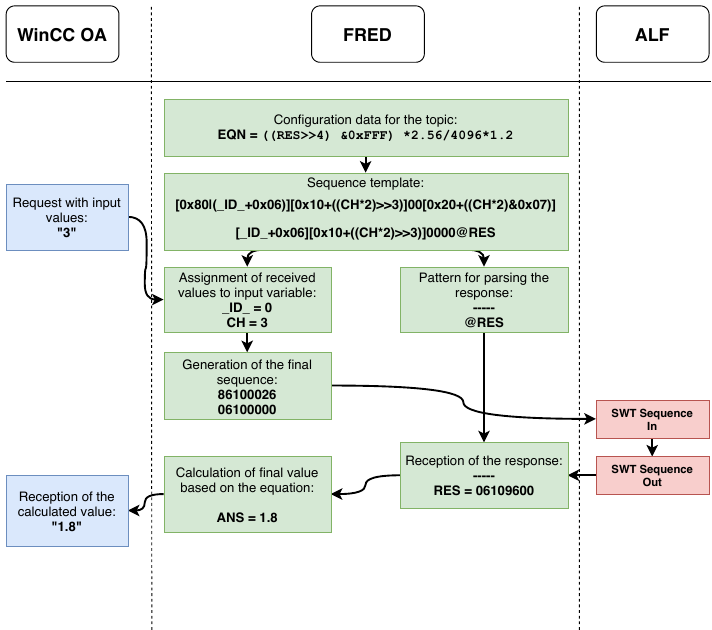
Figure 5. Flowchart of processing the request using the simple mode of the Front End Device